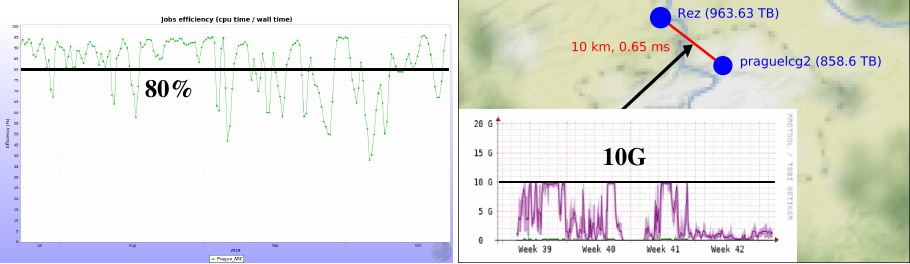
Figure 5. ALICE CPU e ffi ciency and networking usage